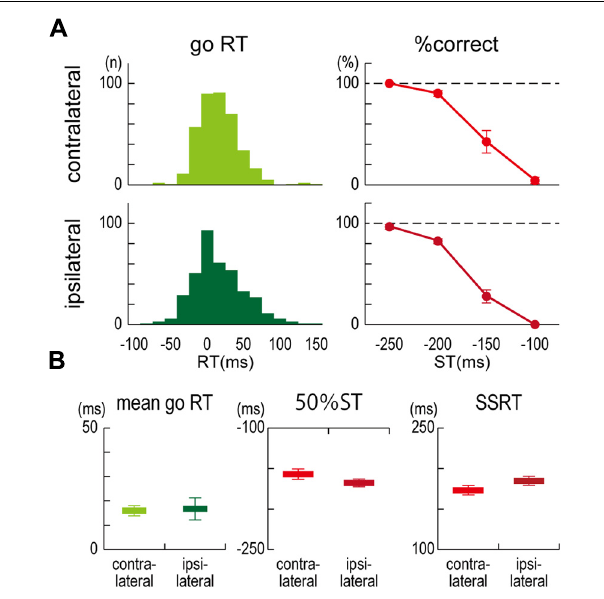
FIGURE 2 |Task performance. (A) Distributions of response time (RT) in go trials withoutTMS and the percentage of correct responses (% correct) in stop trials withoutTMS for each stop time (ST) that was obtained from six participants in contralateral (upper) and ipsilateral (lower)TMS conditions. RT denotes a clicking time relative to the target. (B) Group results of mean go RT (left), estimated 50% STs in stop trials (center), and stop-signal reaction times (SSRTs) in stop trials (right).The 50% ST is an estimated stop time in which the probability of successful stopping was 50%. SSRT is the estimated time required for an unobservable stop process. Error bars show standard error (SE).